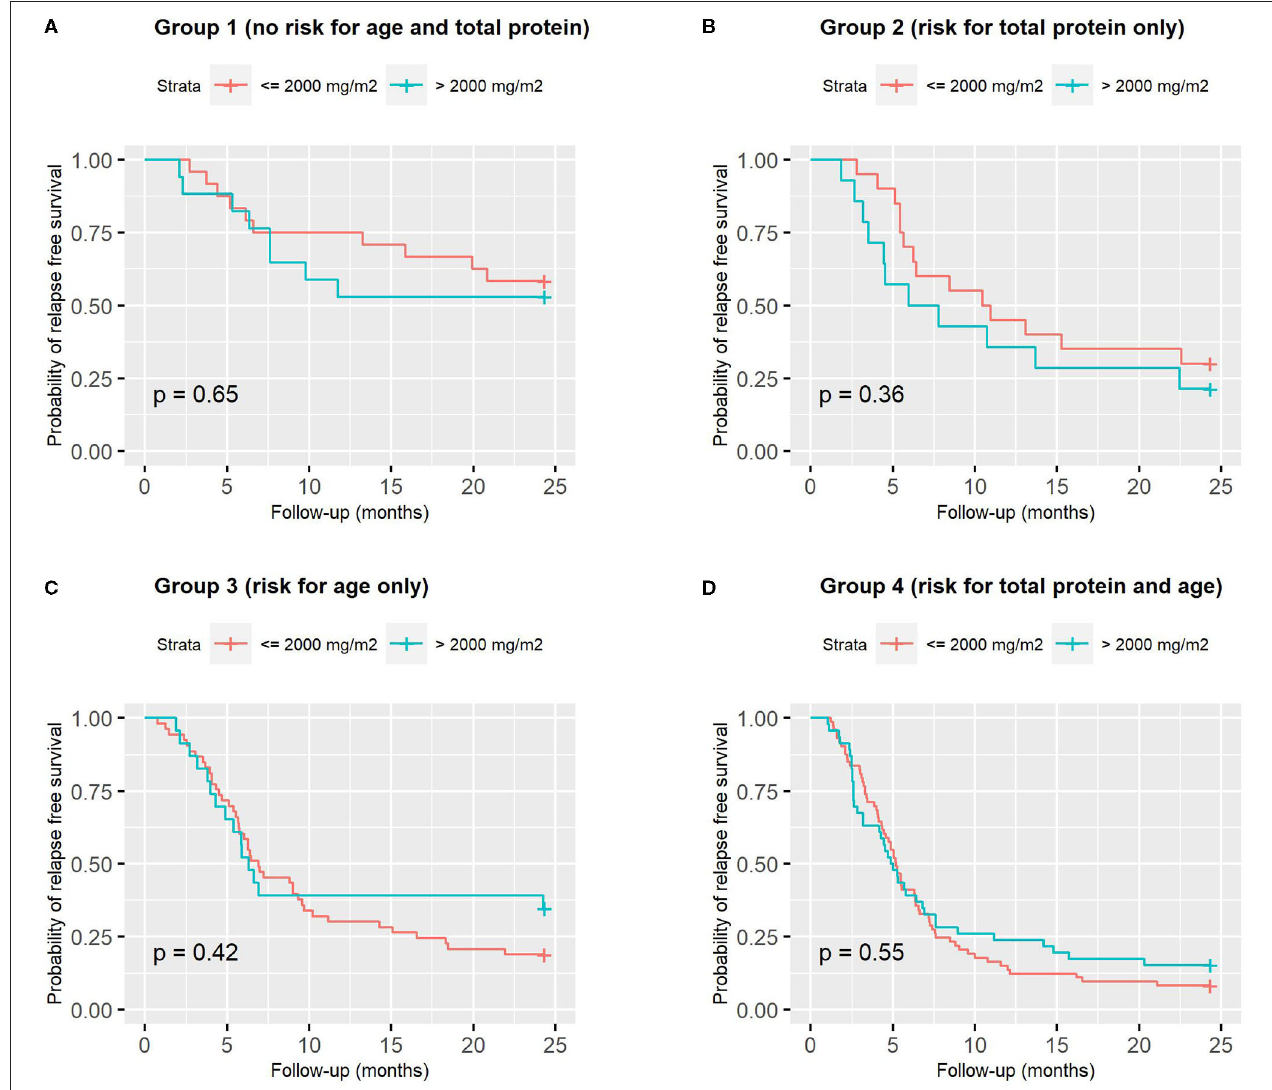
FIGURE 6 | Relapse-free survival curves according to induction prednisone dose in binary form (threshold 2,000 mg/m 2 ), analyzed in each of the 4 combined risk groups based on age (cut-off 5.3 years) and serum protein (cut-off 4.2 g/dl): (A) Group 1, low-risk for both; (B) Group 2, high-risk for total proteins only; (C) Group 3, high-risk for age only; (D) Group 4, high-risk for